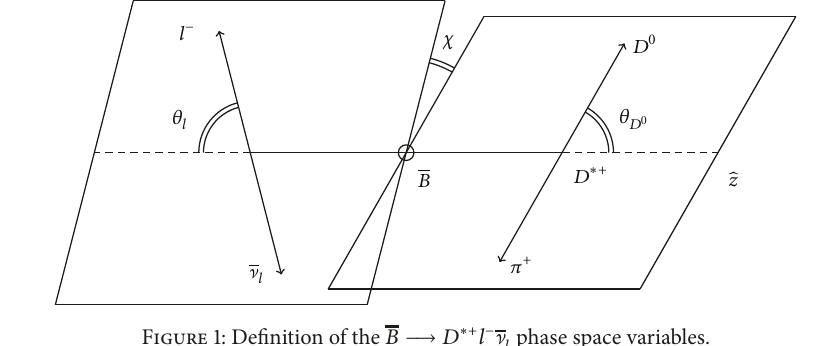
Figure 1: Definition of the 𝐵 󳨀→ 𝐷 ∗+ 𝑙 − ] 𝑙 phase space variables.